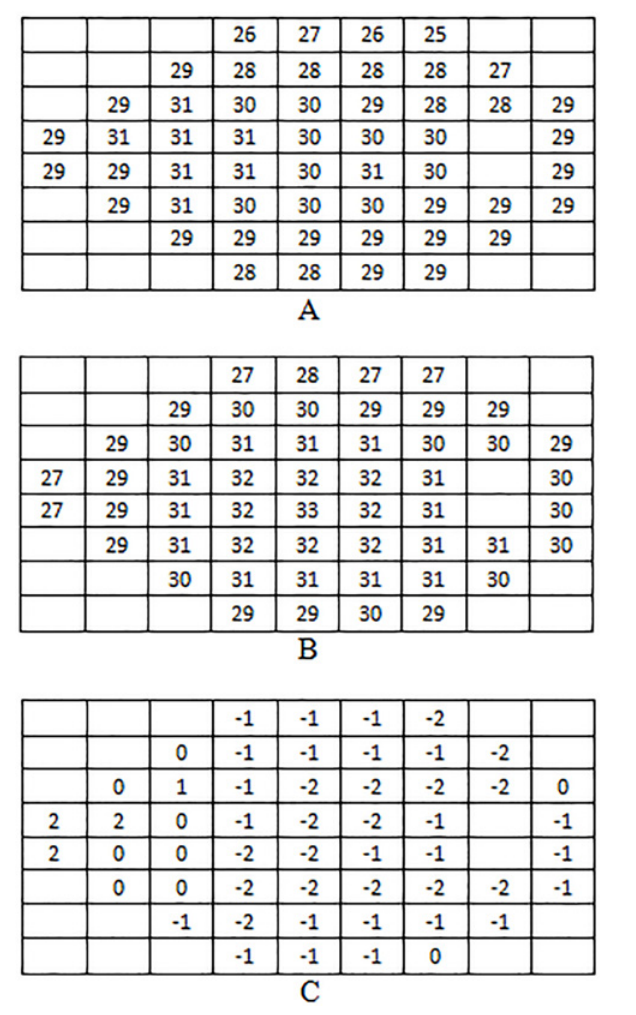
Fig 3. Mean retinal sensitivity at each location for Compass (A), HFA (B), and their difference (C).